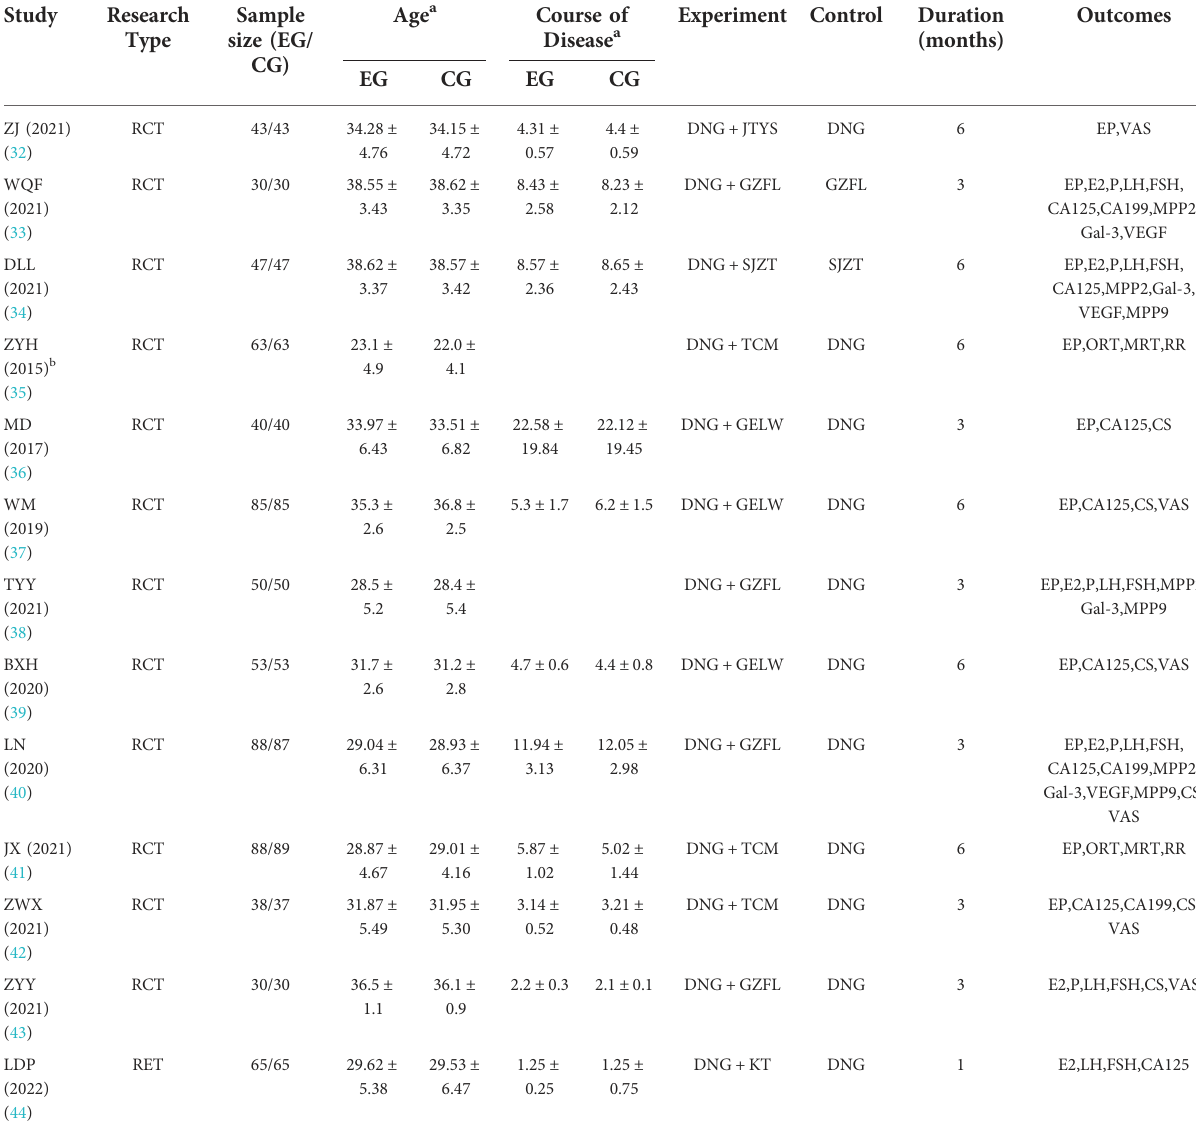
TABLE 1 Characteristics of included